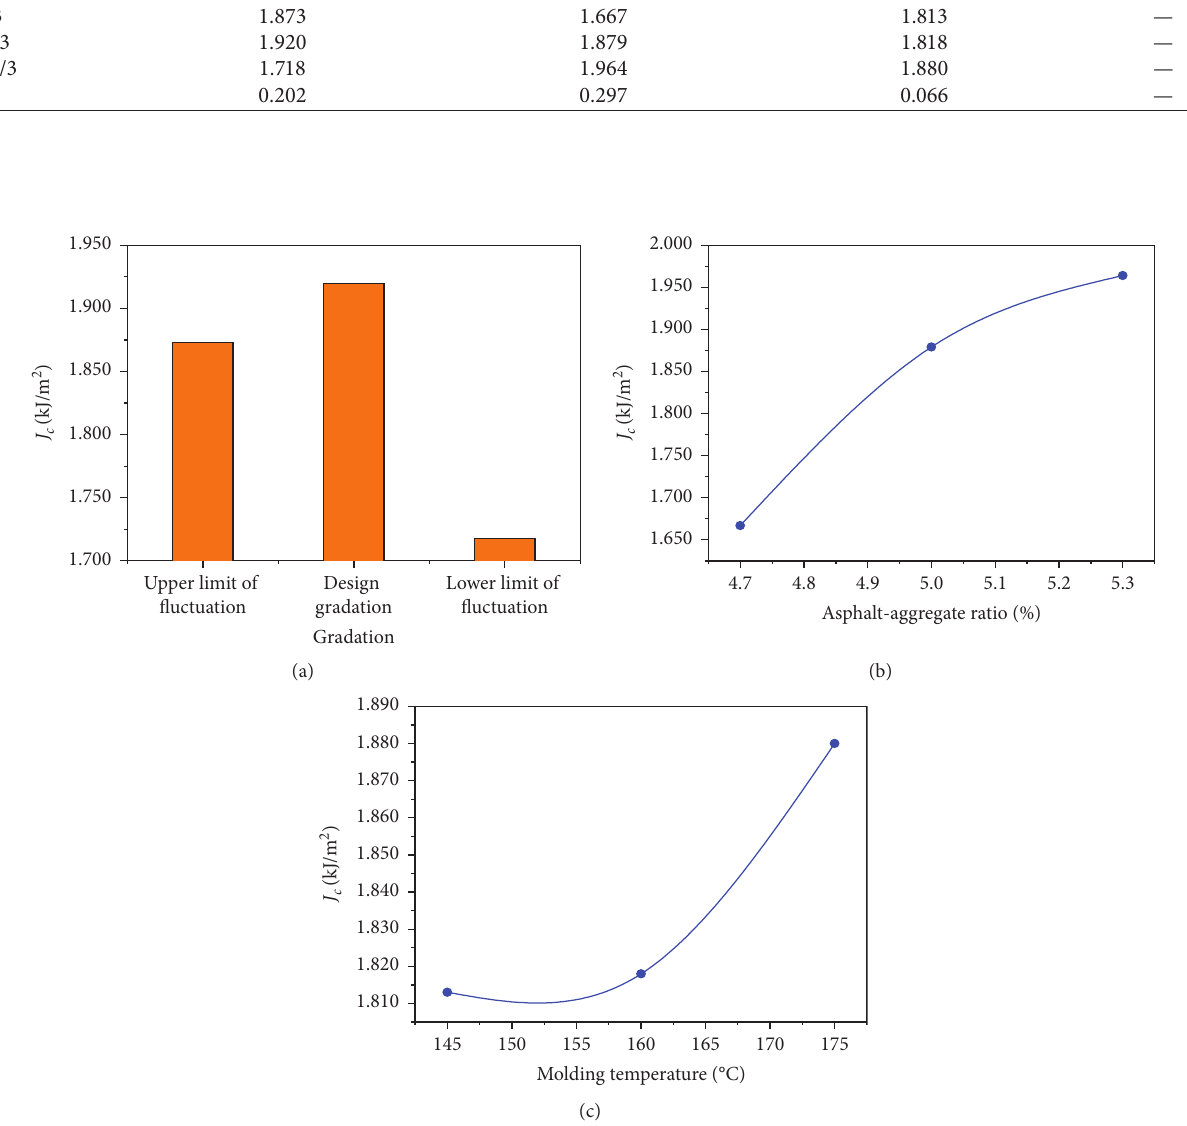
Figure 10: Influence of factor levels on low-temperature